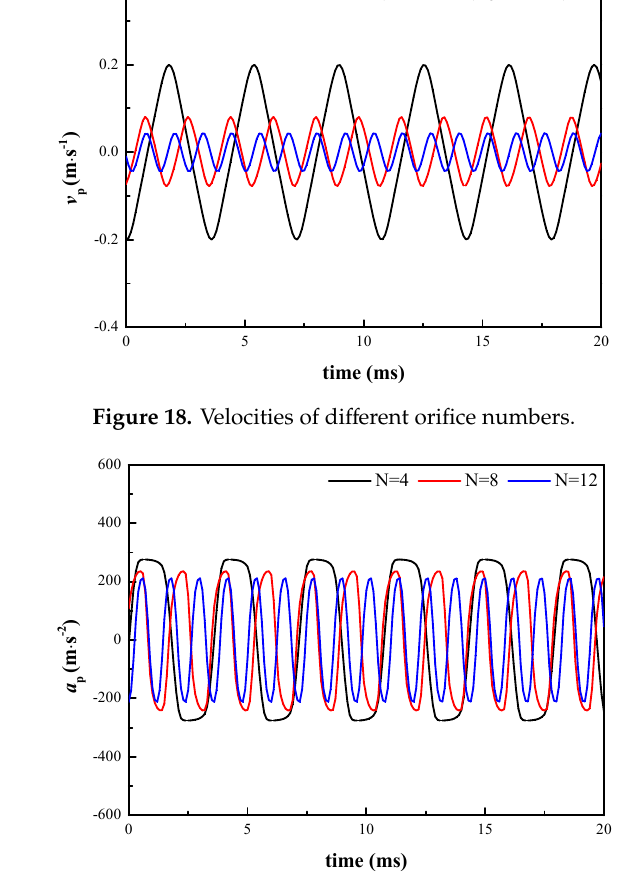
Figure 19. Accelerations of different orifice numbers.